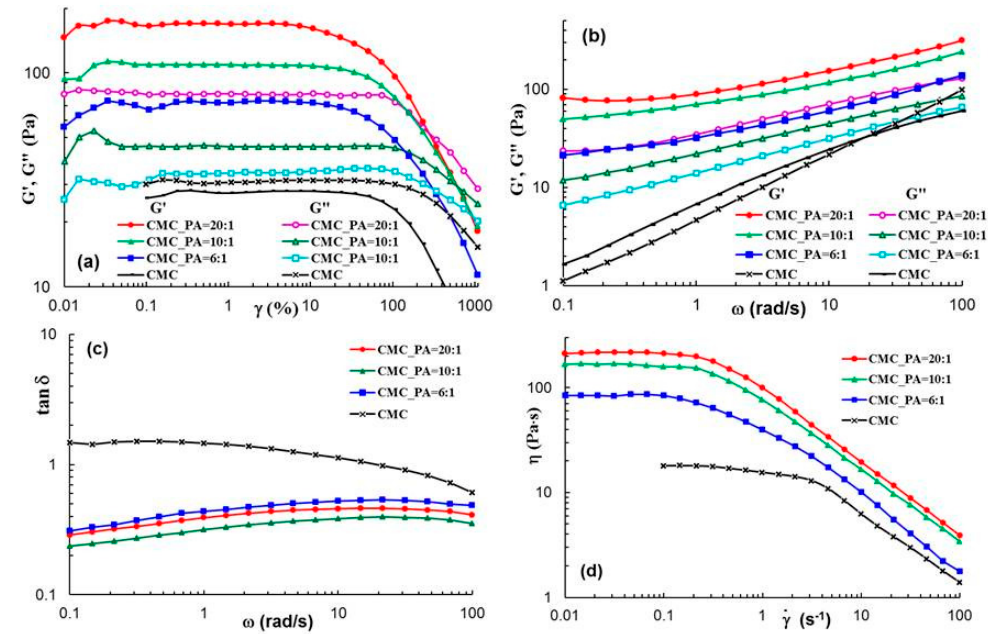
Figure 4. Rheological behavior of the samples in different shear conditions: amplitude sweep ( a ), frequency sweep ( b , c ) and shear flow ( d ) at 25 °C.